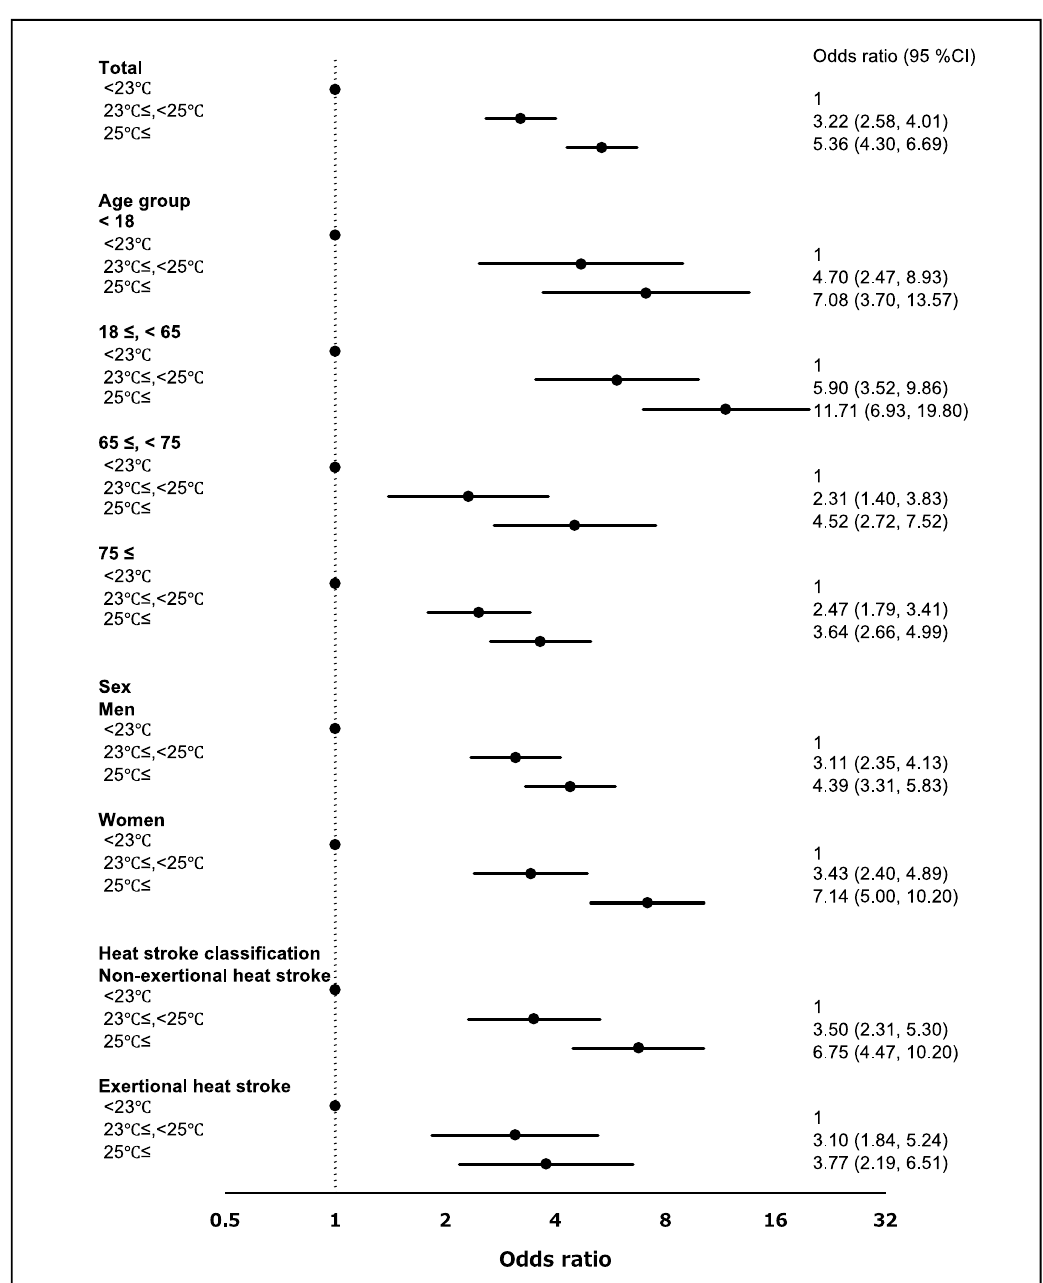
Figure 4. Risk of developing a heat stroke by minimum air temperature and stratified by age, sex and heat stroke classification. The black dots mean the odds ratio. Numbers in parentheses are the 95% confidence intervals (95% CI).